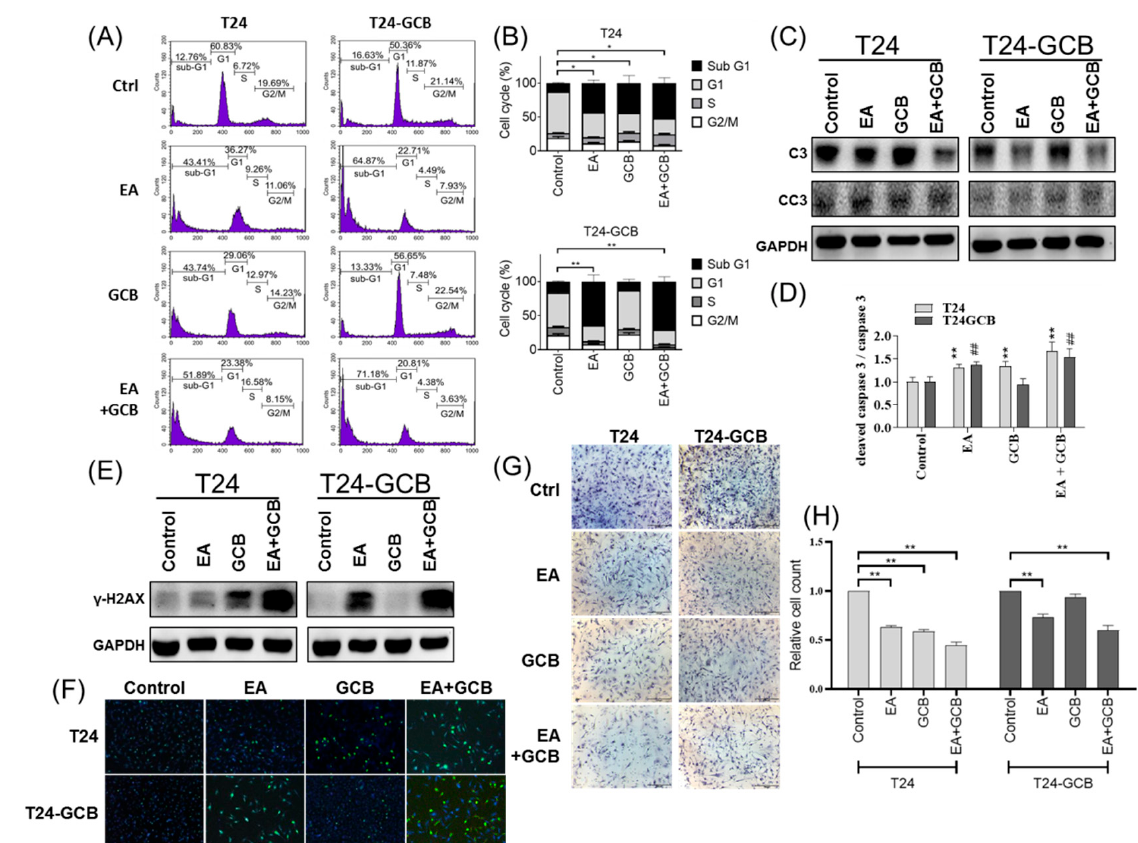
Figure 2. ( A ) Comparison of the cell cycle distribution of T24 and T24-GCB cells among the PBS control, EA (30 µM), GCB (0.1 µM) and EA (30 µM) +GCB (0.1 µM) groups. ( B ) Quantitative bar chart of the cell cycle distribution among the treated groups. ( C ) Protein expression levels of procaspase 3 (C3) and cleaved caspase 3 (CC3) compared among the same groups. ( D ) Quantitative bar chart of C3 and CC3 expression among the treated groups. ( E ) Protein levels of γ -H2AX, a DNA double-strand breakage marker, compared among the same groups. ( F ) Results of the γ -H2AX foci assay compared among the same groups. ( G ) Results of the Matrigel-coated Transwell invasion assays compared among the same groups. ( H ) Quantitative bar chart of migrated cells among the treated groups. All statistical tests were analyzed with Student’s t test with significance at * < 0.05, ** < 0.01 (or ## < 0.001).